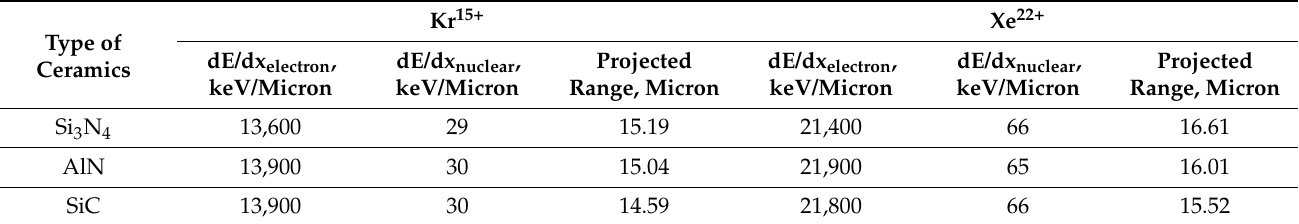
Table 1. Data on the energy losses of the incident